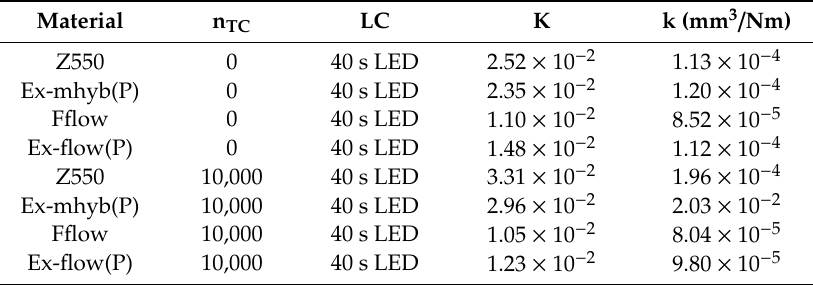
Table 2. Results of friction wear